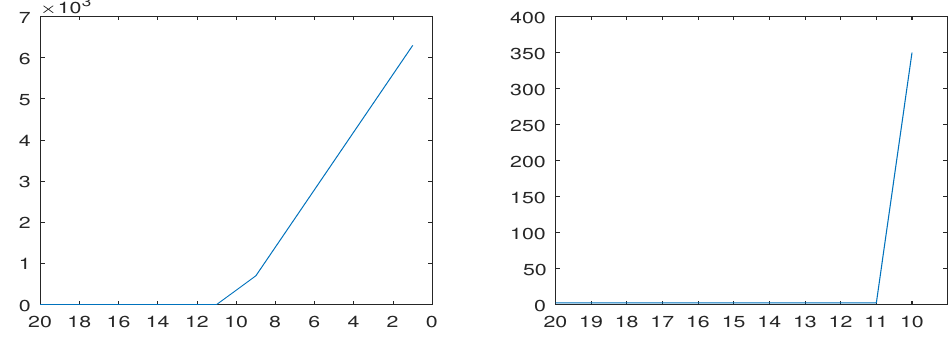
Figure 6: Left side: | λ 20 ( A n ) | < ··· < | λ 1 ( A n ) | ; right side: | λ 20 ( A n ) | < ··· < | λ 10 ( A n ) | in a typical realization in case (a) of